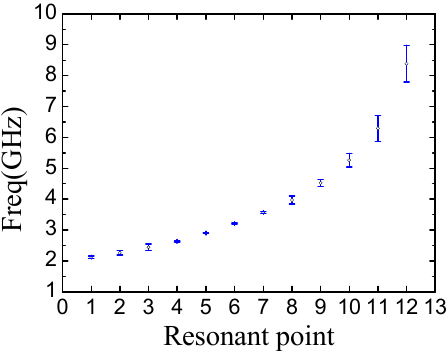
Figure 14. Statistic results on the distribution of the errors of the twelve resonant points.